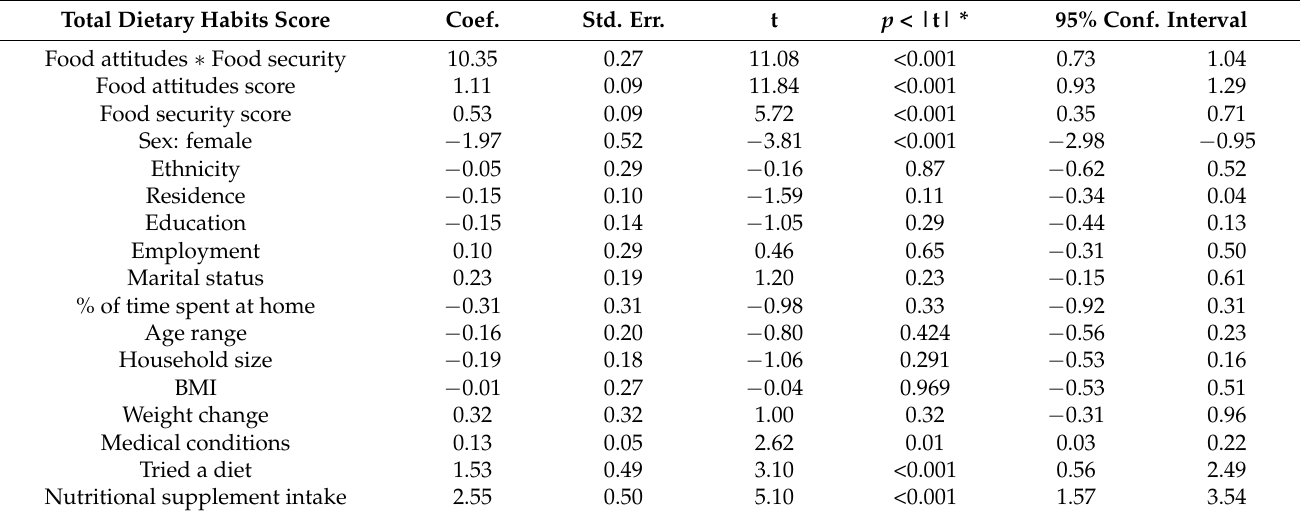
Table 5. Multiple linear regression of food attitudes, food security, demographics, and total dietary habit scores ( n = 2036).